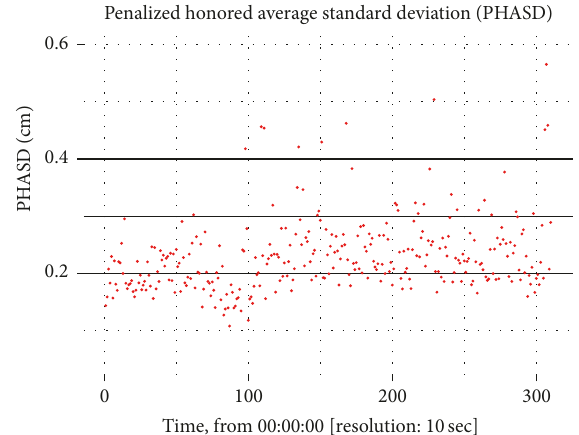
Figure 16: Computed penalized honored average standard devia- tion. Horizontal lines are used for classification. Baseline of ∼ 41 km, year: 2014, DOY: 85.